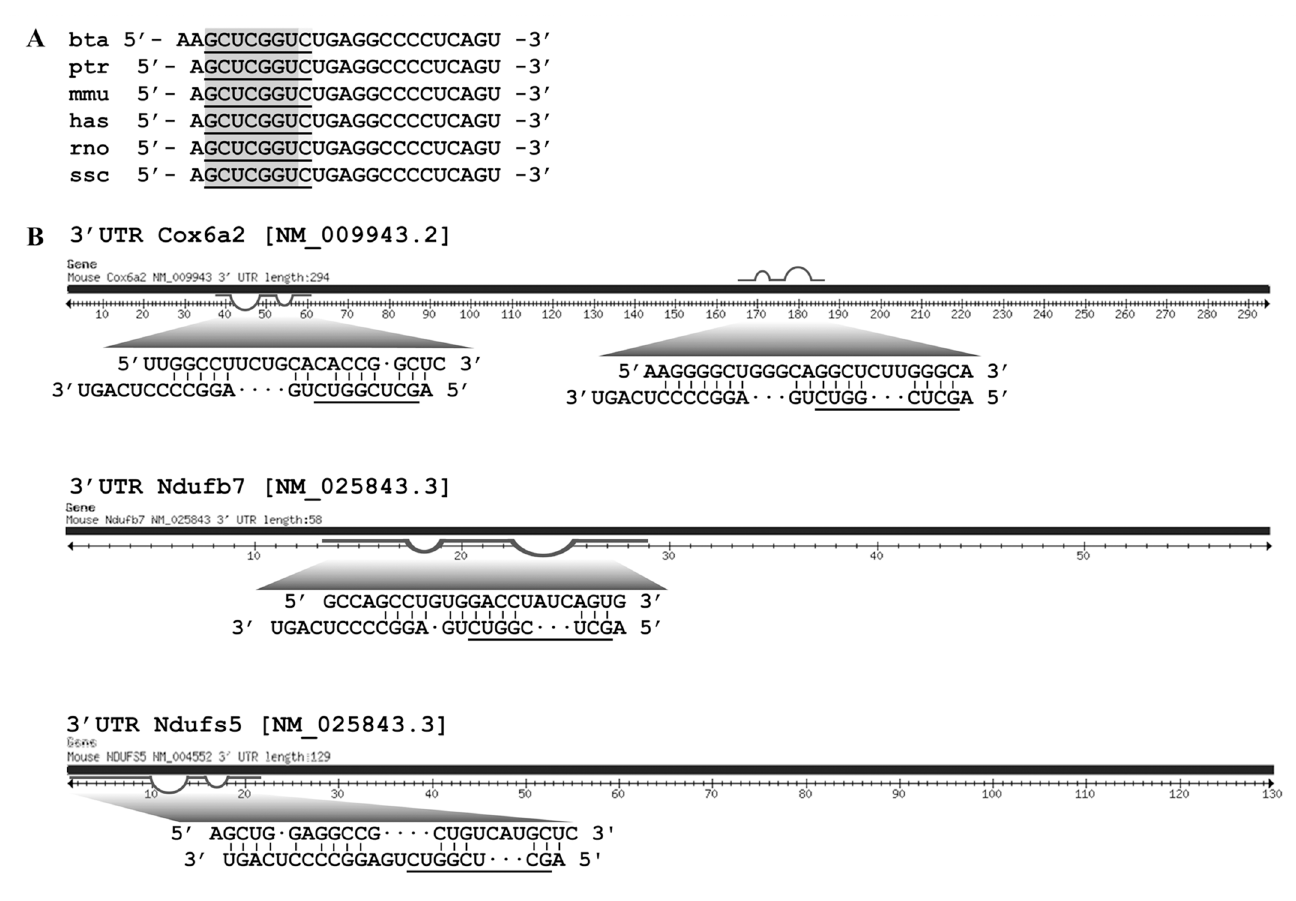
Fig 7. miR-423-3p as a candidate miRNA for functional validation. (A) Conservation of miRNA-423-3p across species; Bos taurus (bta), Pan troglodytes (ptr), Mus musculus (mmu), Homo sapiens (hsa), Rattus norvegicus (rno), and Sus scrofa (ssc). The seed region (2 – 8 nt) is highlighted in a gray box and underlined. (B) Predicted targets of mmu-miR-423-3p in the 3 0 -UTR of Cox6a2, Ndufb7, and Ndufs5 (RNAhybrid). The prediction criteria include free energy (cid:3) -20 kcal/mol and allowing the G:U wobble base-pair and bulging nucleotides in the seed region. The seed match is